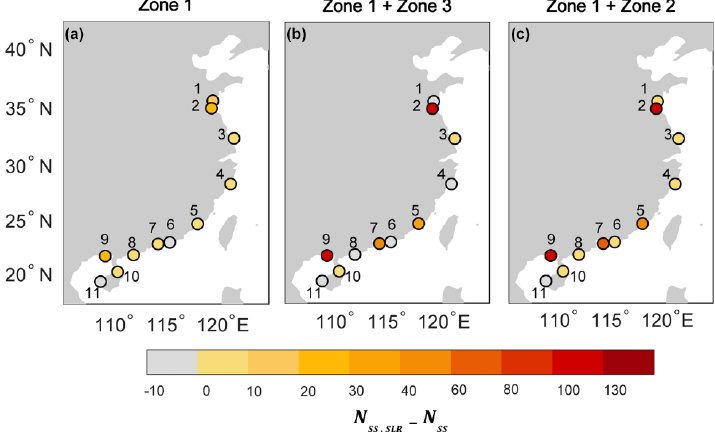
Figure 6. Count of joint occurrences between storm surge and precipitation with/without mean sea level influence at threshold of 98%. N SS + SLR indicates joint occurrences considering historical sea level rise trend. N SS indicates joint occurrences after removing the effects of sea level rise. (a) Zone 1; (b) Zone 1 + Zone 3; (c) Zone 1 + Zone